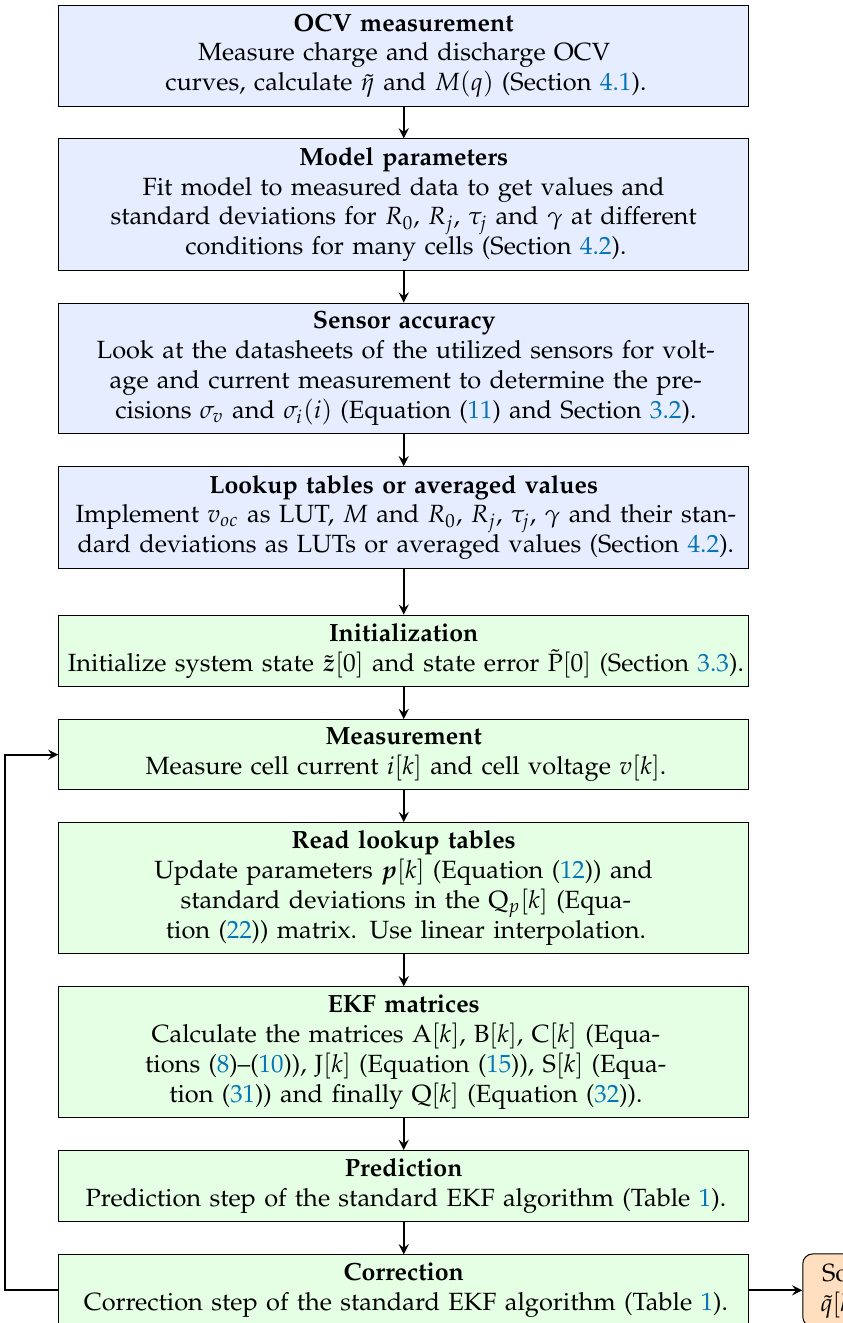
Figure 5. Steps before (blue) and during operation (green) of the proposed EKF for SoC estimation of a lithium-ion battery